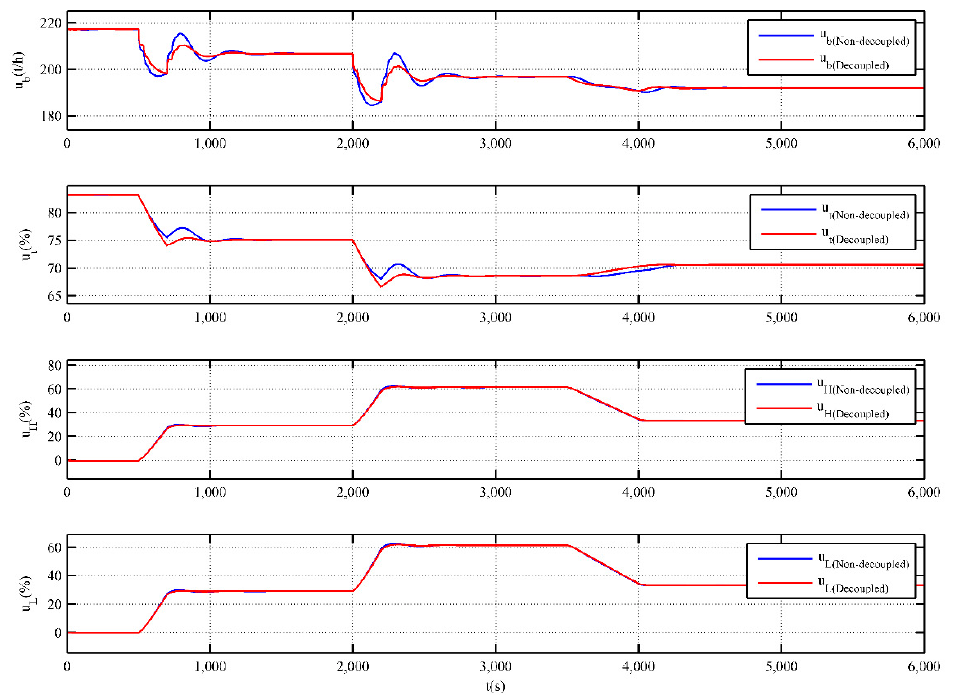
Figure 5. Curves for controlled variables.